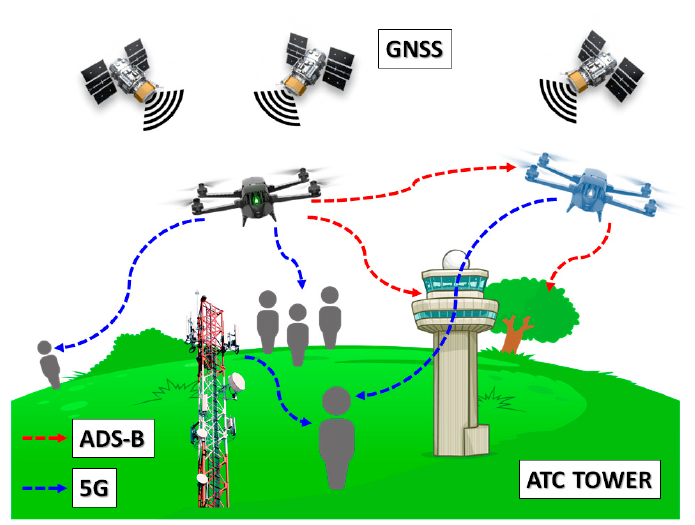
Figure 3. The envisaged UAVs applications, operating 5G services (blue dashed arrow) for users at ground level while improving DAA awareness via ADS-B (red dashed arrow).